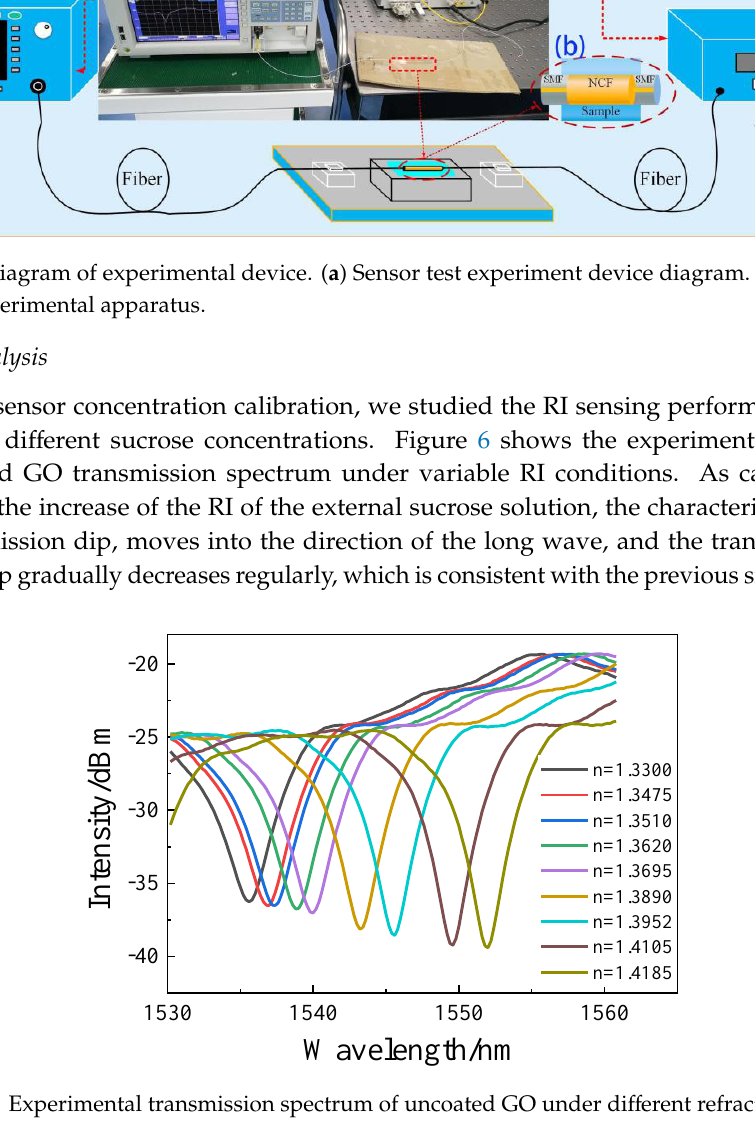
Figure 7. The sensitivity and linearity of the wavelength with varying RI (simulation and experiment).